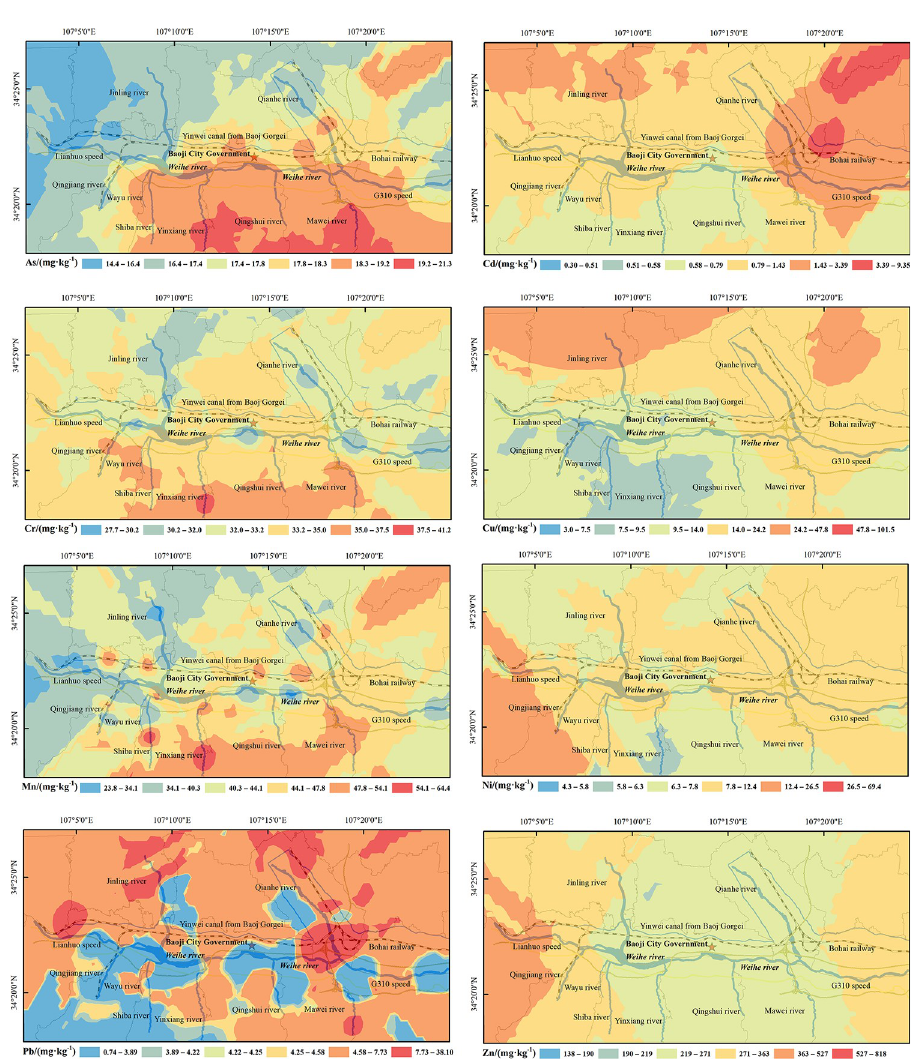
Fig 3. Distribution maps of heavy metal content in soil around the river in Baoji